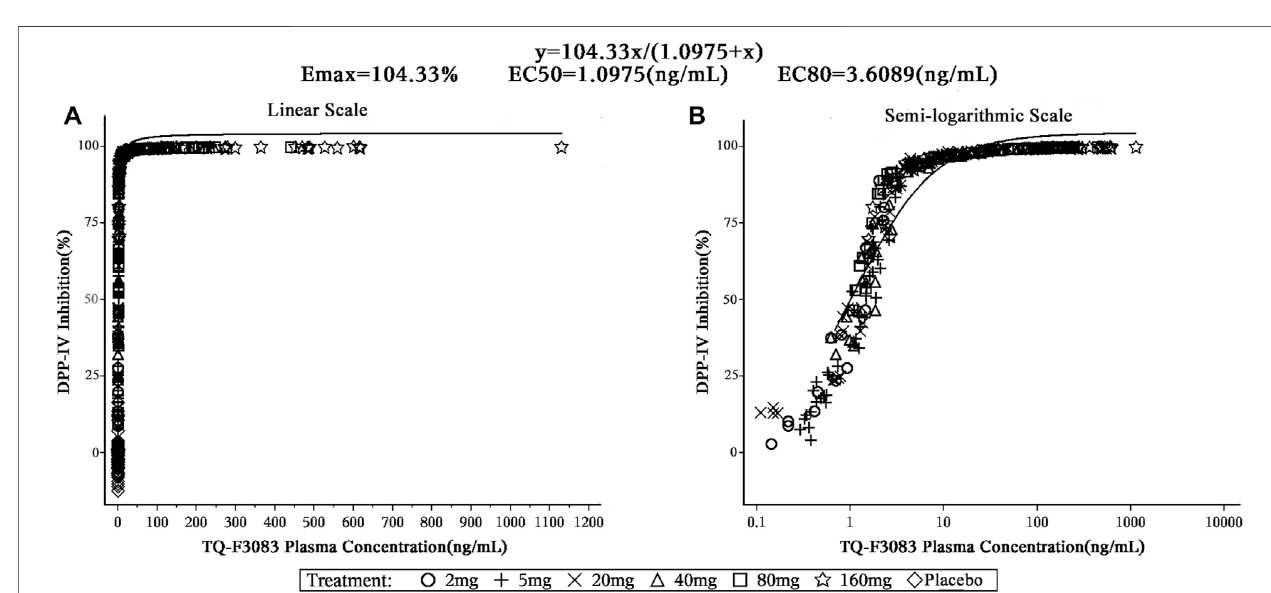
FIGURE 5 | Correlation between plasma TQ-F3083 concentration and DPP-4 inhibition.